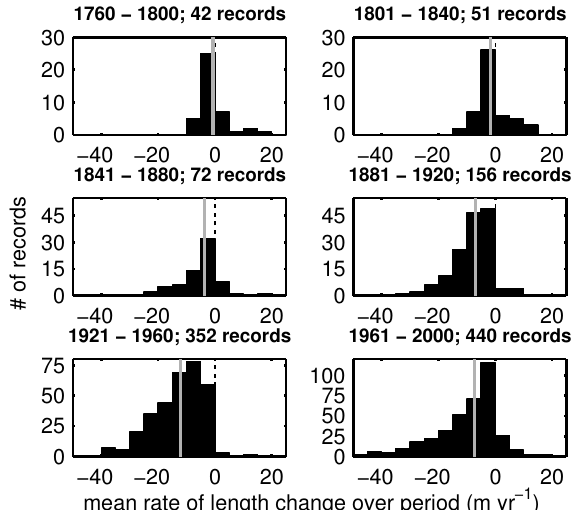
Fig. 8. Mean rate of length change (ma − 1 ) of the available glacier length records for six 40-year periods between 1760 and 2000. The median rate of length change of all glaciers in that period is given by a grey line. Note the changing number of glacier length records for the different